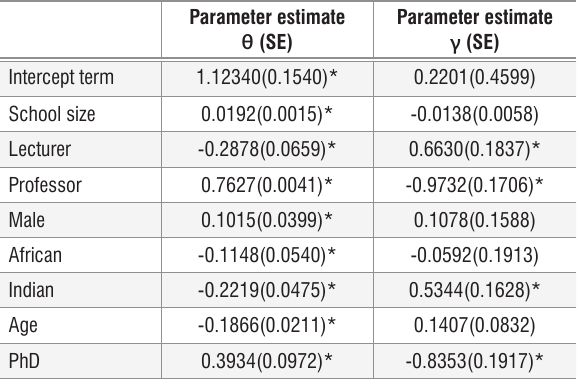
Parameter estimates for θ and γ in the zero-inflated Poisson model